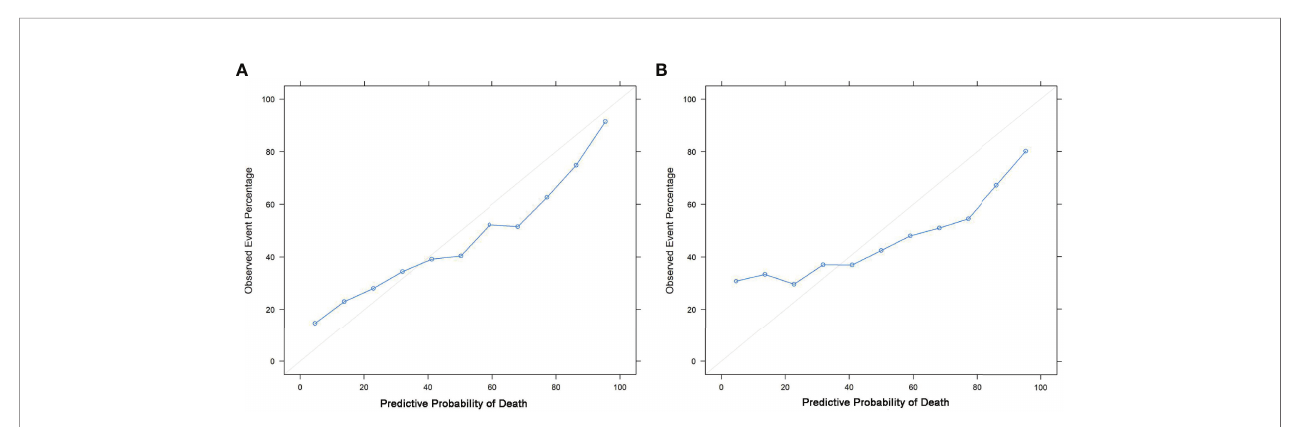
FIGURE 4 | Calibration curves. Calibrations of the probabilities of CMM-caused death among patients with solitary CMM (A) and CMM with multiple tumors (B) based on validation sets.